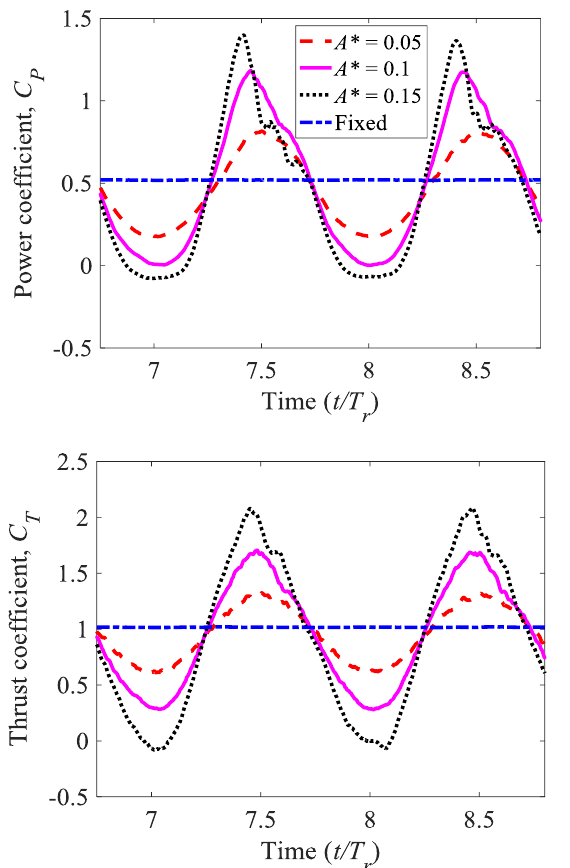
Fig. 11. Time histories of power (top) and thrust (bottom) coefficient for fixed and surging turbine at 𝐴 ∗ = 0.05, 0.10, 0.15 at fixed values of 𝜆 = 4.4 and ω* = 1.0. T ABLE II